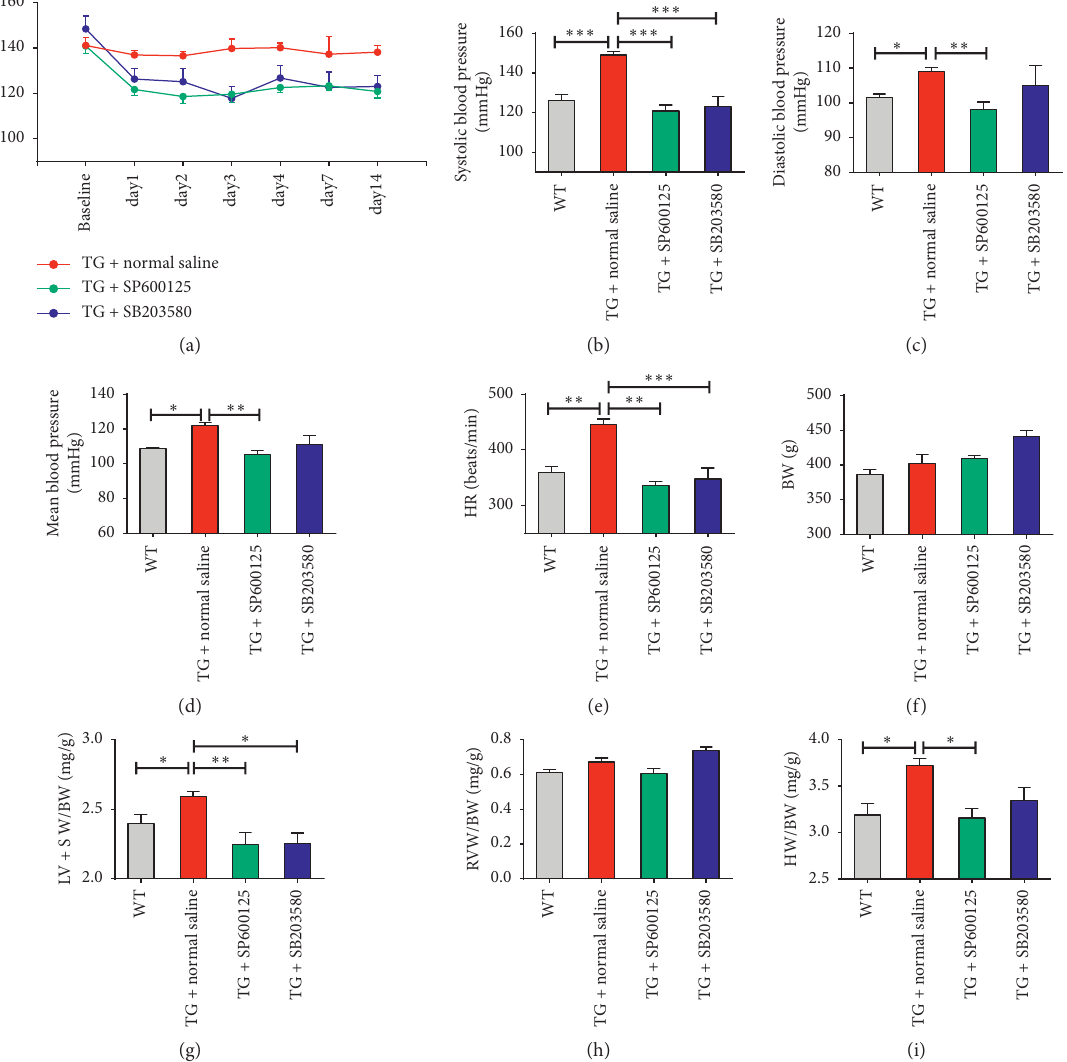
Figure 1: p38/JNK was required for elevated blood pressure and left ventricular hypertrophy mediated by L3MBTL4 . (a) The systolic blood pressure (SBP) in TGs, compared with TG+SP600125 and TG+SB2003580. (b)–(f) SBP, diastolic blood pressure (DBP), mean blood pressure (MBP), heart rate (HR), and bodyweight (BW) of WTs, TG+normal saline, TG+SP600125, and TG+SB2003580 ( n � 5 each group). (g)–(i) Quantitative analysis of left ventricle +septum weight/bodyweight (LV +SW/BW), right ventricle weight/bodyweight (RVW/BW), and heart weight/bodyweight (HW/BW) ratios in each group ( n � 5 each group). ∗ p < 0 . 05; ∗∗ p < 0 . 01; ∗∗∗ p < 0 . 001. All data represent mean ±